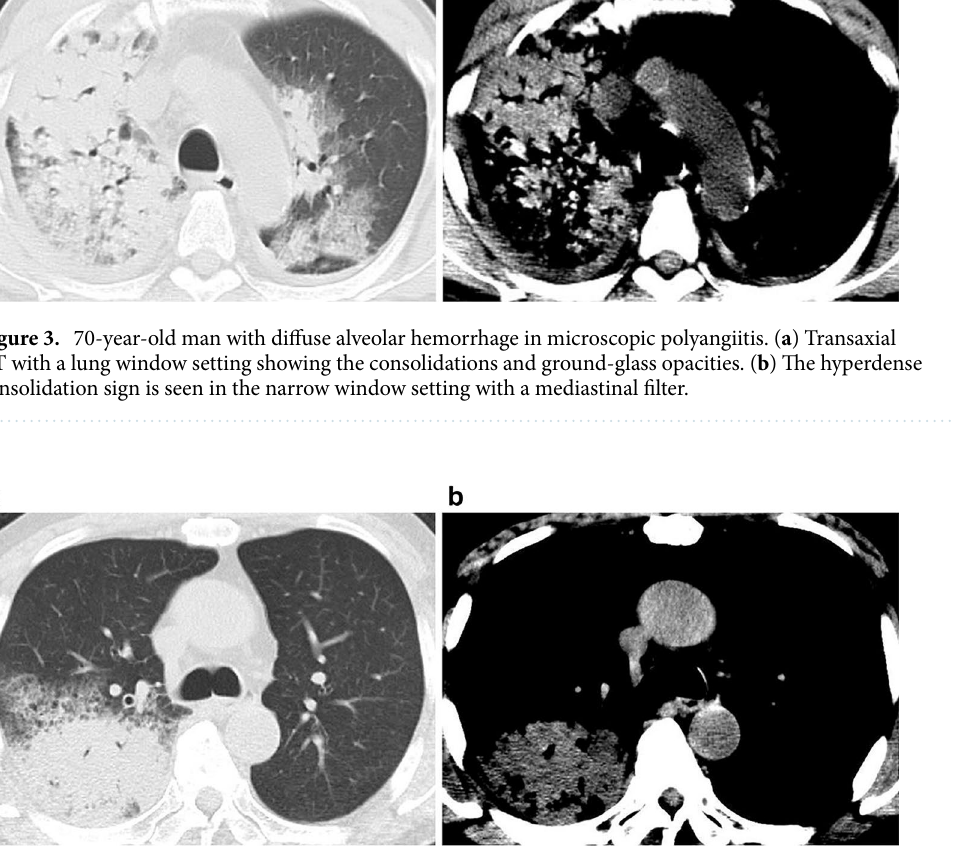
Figure 4. 77-year-old man with bacterial pneumonia. ( a ) Transaxial CT with a lung window setting showing consolidations in the right lung. ( b ) In the narrow window setting with a mediastinal filter, the